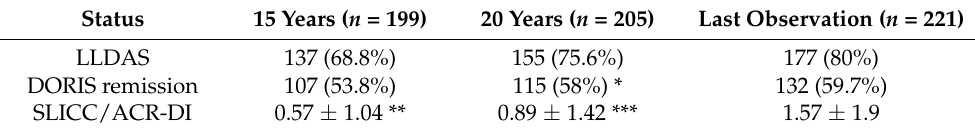
Table 2. LLDAS, remission ad SLICC/ACR-DI indexes at long-term endpoints.